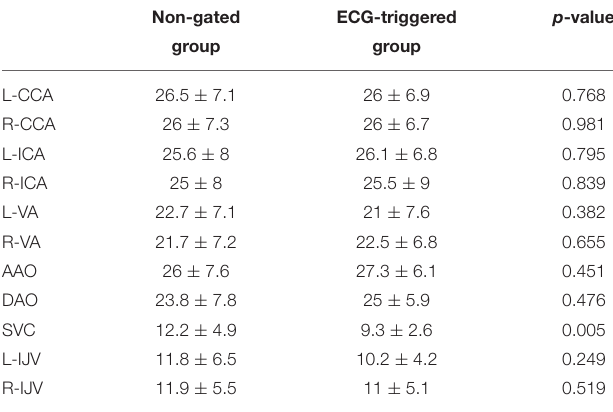
TABLE 3 | Quantitative analysis of image quality (CNR).